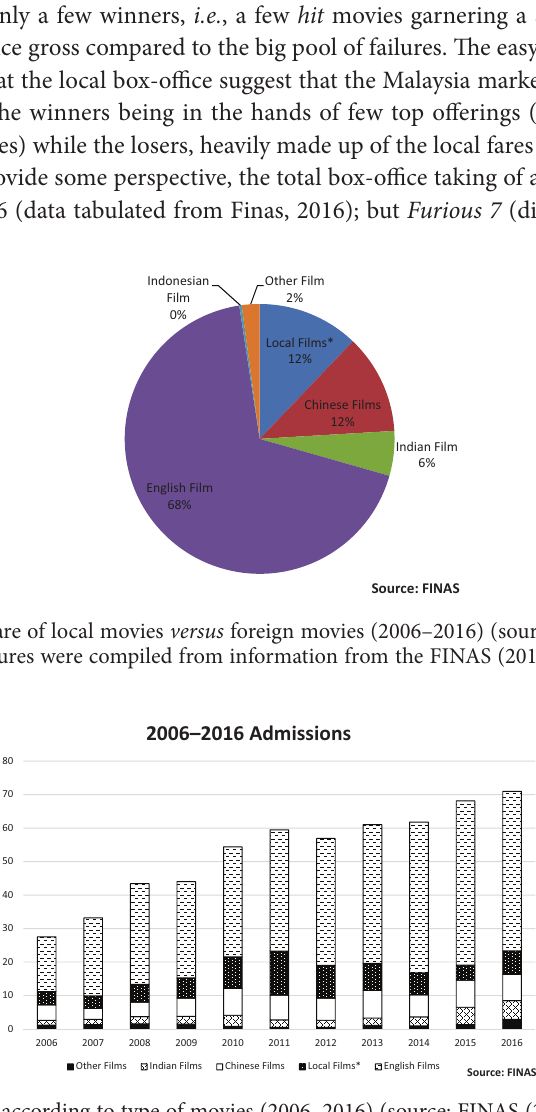
Figure 3. Admissions according to type of movies (2006–2016) (source: FINAS (2019b) (figures were compiled from information from the FINAS